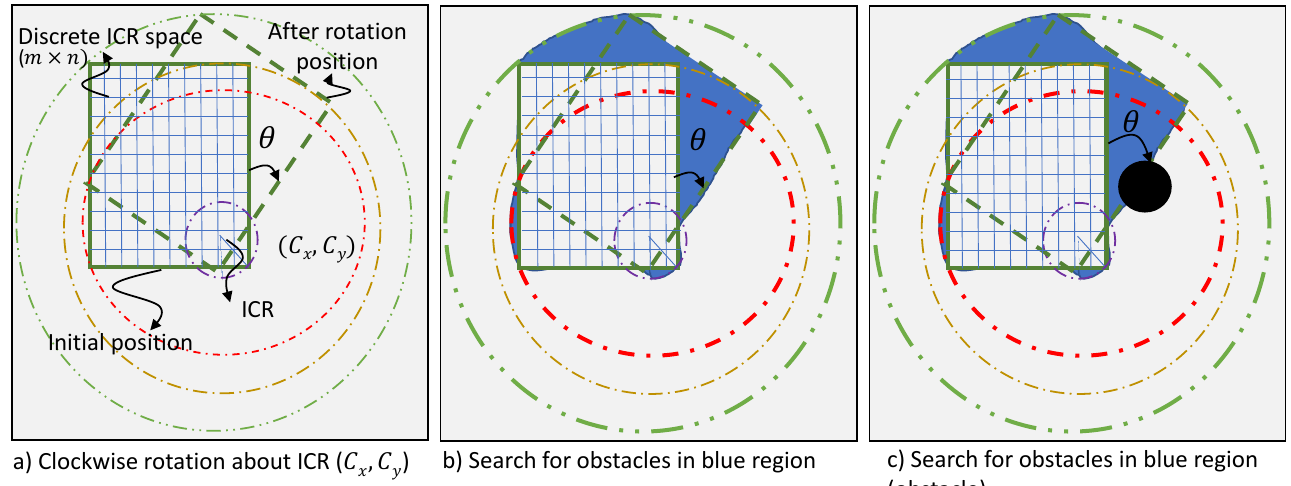
Figure 6. Search for feasible ICR within the robot footprint and collision